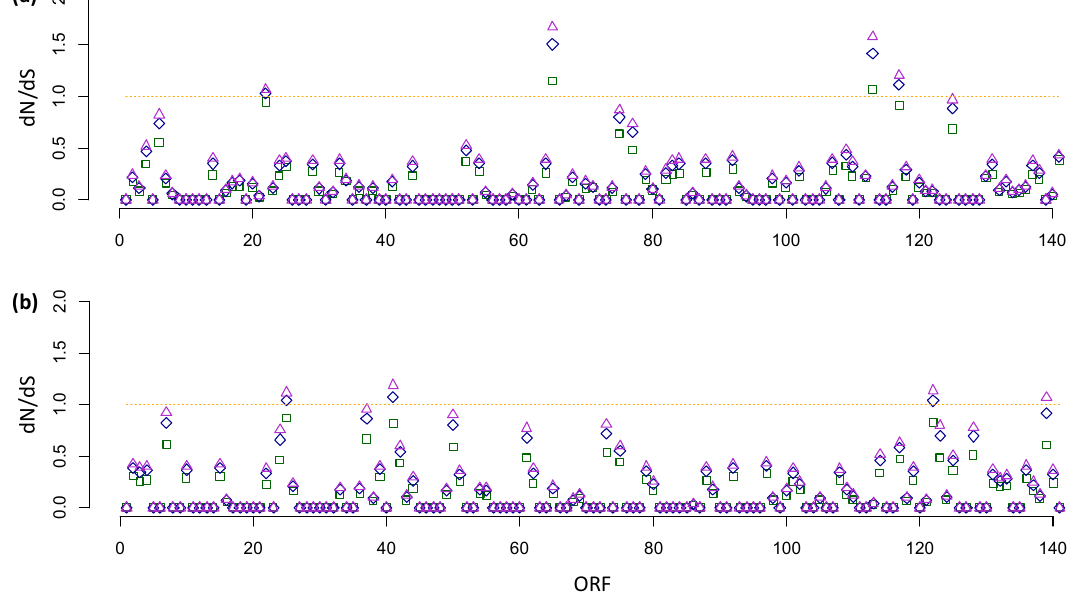
Figure 2. The ratio of the rate of nonsynonymous to the rate of synonymous substitution (dN / dS) analyses for fixed single nucleotide polymorphisms (SNPs), where in both panels the x-axis is the open reading frame (ORF) number corresponding to the SpltMNPV-G2b reference and the y-axis is the dN / dS value. dN / dS values assuming di ff erent mutational biases are presented: transition to transversion ratio (TTR) values of 1 (green squares), 3 (blue diamonds), and 5 (magenta triangles). The orange line indicates dN / dS = 1, which indicates neutral evolution. When dN / dS < 1, there is purifying selection, whereas when dN / dS > 1 there is positive selection. ( a ) Results for the analysis of shared mutations (mutations that are found in both Pakistani isolates but not in SpltNPV-G2b), based on the resequencing approach. ( b ) Results for the analysis of unique mutations found only in one of the Pakistani isolates. For details of the analysis for all ORFs with a result ≥ 1, see Table 3.